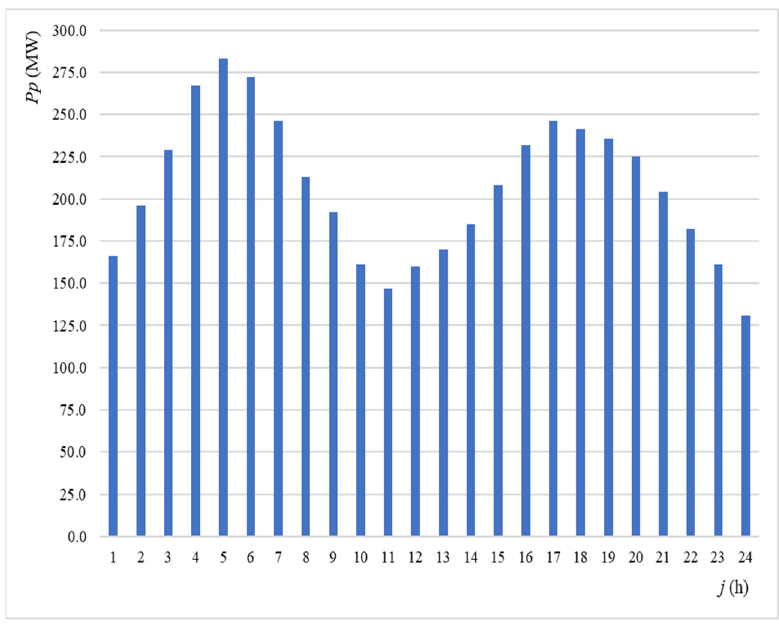
Figure 4. Daily load diagram of the IEEE 30 bus system.